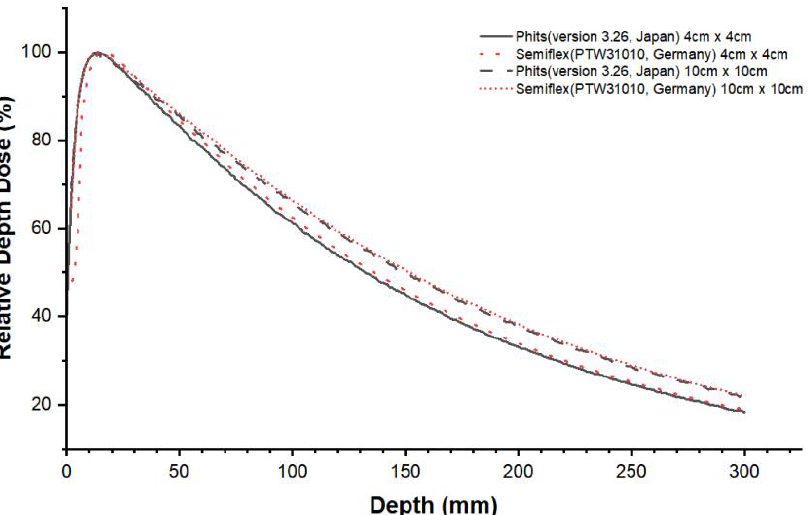
Figure 6. Superimposed measured and simulated PDD values for Varian Clinac 6MV: It was evaluated by dividing by field size (4 cm × 4 cm, 10 cm × 10 cm). Table 5. Prior to cluster evaluation, calculations were performed with three processors each to compare individual node performance. Node CPU time (h) is the average of the results of repeating the same operation five times. Avg is the average value at this time, and SD is the standard deviation of the measured value.